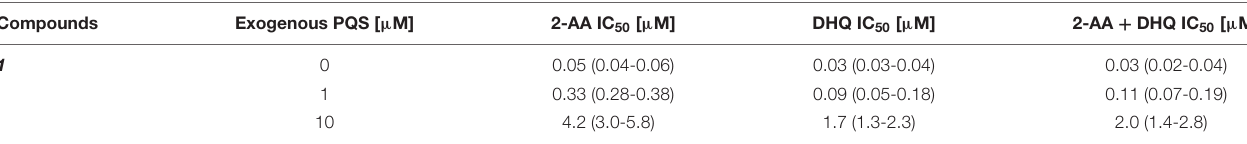
The data are reported with 95% Confidence